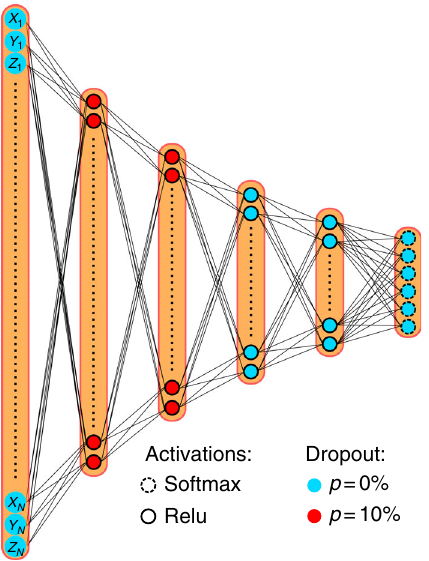
Fig. 3 Representative structure of one lobe of the VAMPnet used for alanine dipeptide. Here, the fi ve-layer network with six output states used for the results shown in Fig. 4 is shown. Layers are fully connected, have 30-22-16-12-9-6 nodes, and use dropout in the fi rst two hidden layers. All hidden neurons use ReLu activation functions, while the output layer uses Softmax activation function in order to achieve a fuzzy discretization of state space